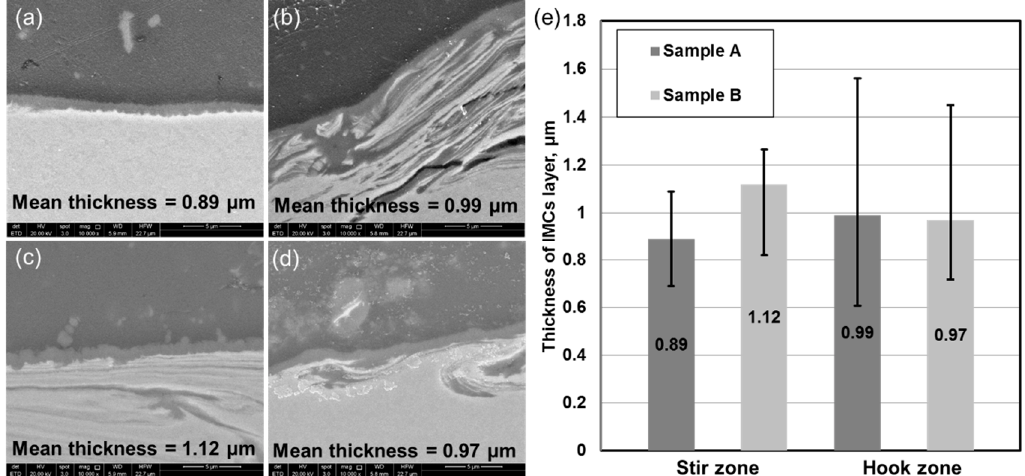
Figure 8. SEM images for evaluating the thickness of intermetallic compounds: ( a ) stir zone of sample A, ( b ) hook zone at retreating side of sample A, ( c ) stir zone of sample B, ( d ) hook zone at retreating side of sample B, and ( e ) thicknesses of interfacial layers.